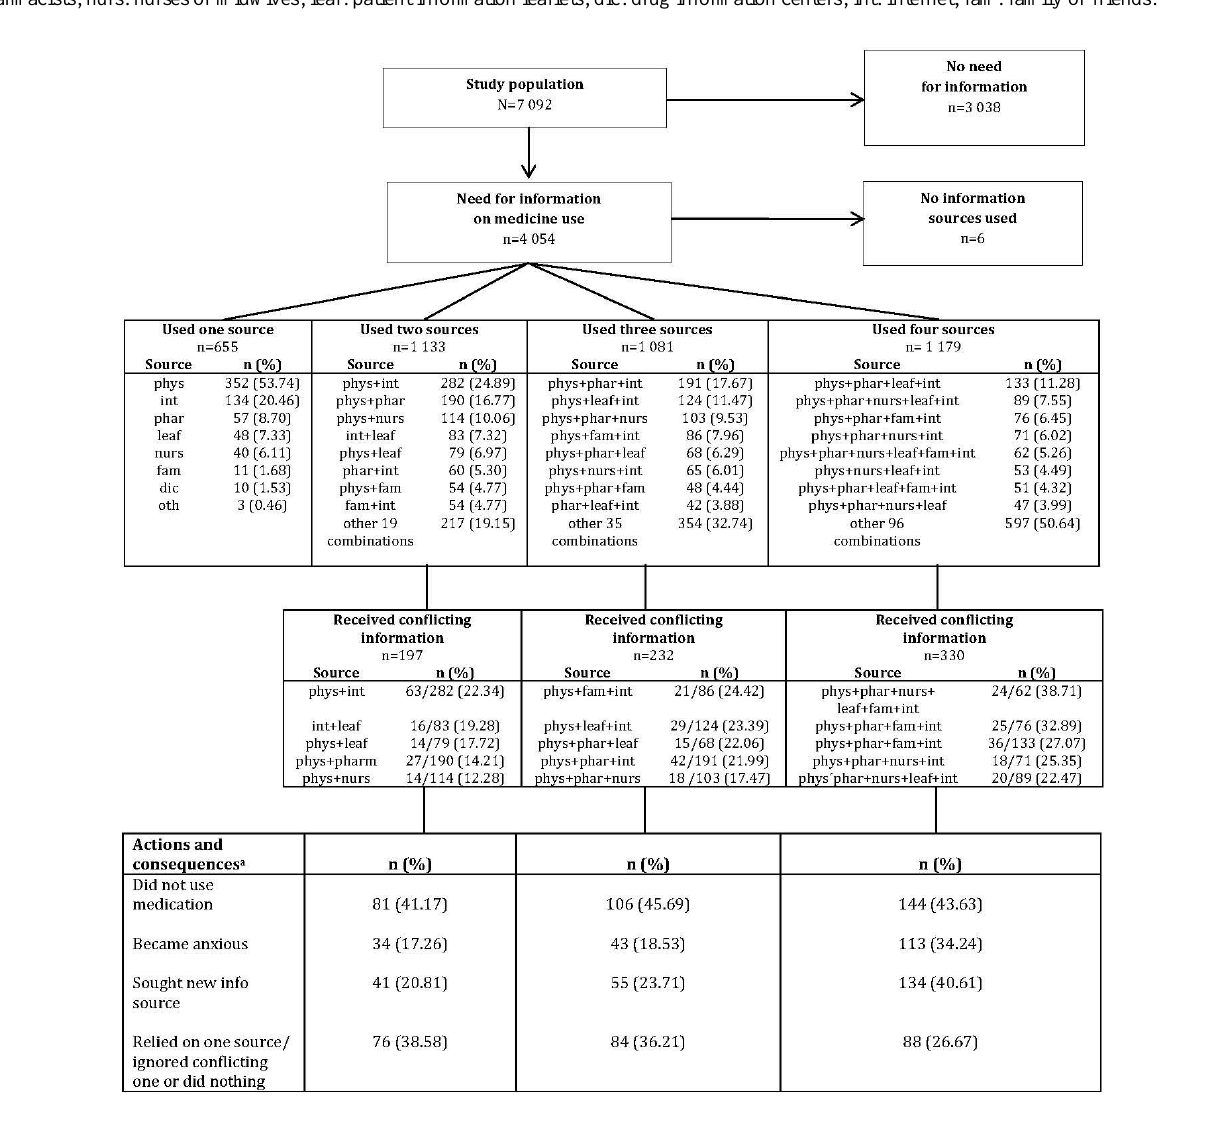
Figure 1. Need for information on medicine use including actions and consequences ensuing from conflicting information. Phys: physicians;